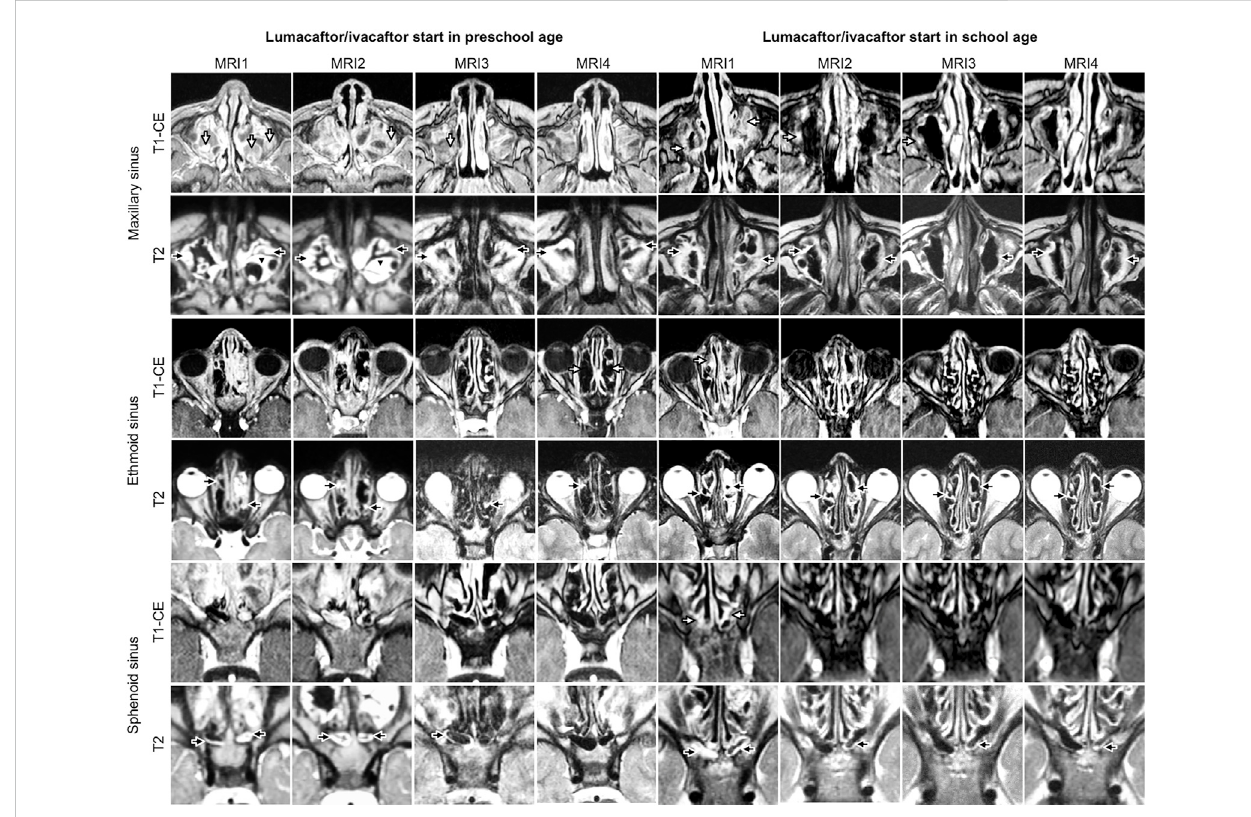
FIGURE 1 Representative examples of longitudinal magnetic resonanceimagingof chronic rhinosinusitisparansal sinus abnormalities before (MRI1) and under therapy with lumacaftor/ivacaftor (MRI2-4) in children with cystic fi brosis starting lumacaftor/ivacaftor therapy in preschool and school age. Mucosal swelling is indicated by black arrows, mucopyoceles by white arrows and polyps by black arrowheads. Note the reduction of mucopyoceles in the maxillary sinus in the patient starting therapy in school age. The chronic rhinosinusitis magnetic resonance imaging (CRS-MRI) score in the patient starting therapy in preschool age (4 years at MRI1) was in MRI1 33, in MRI2 33, in MRI3 30 and in MRI4 29 and in the patient starting therapy in school age (9 years at MRI1) in MRI1 32, in MRI2 30, in MRI3 27 and in MRI4